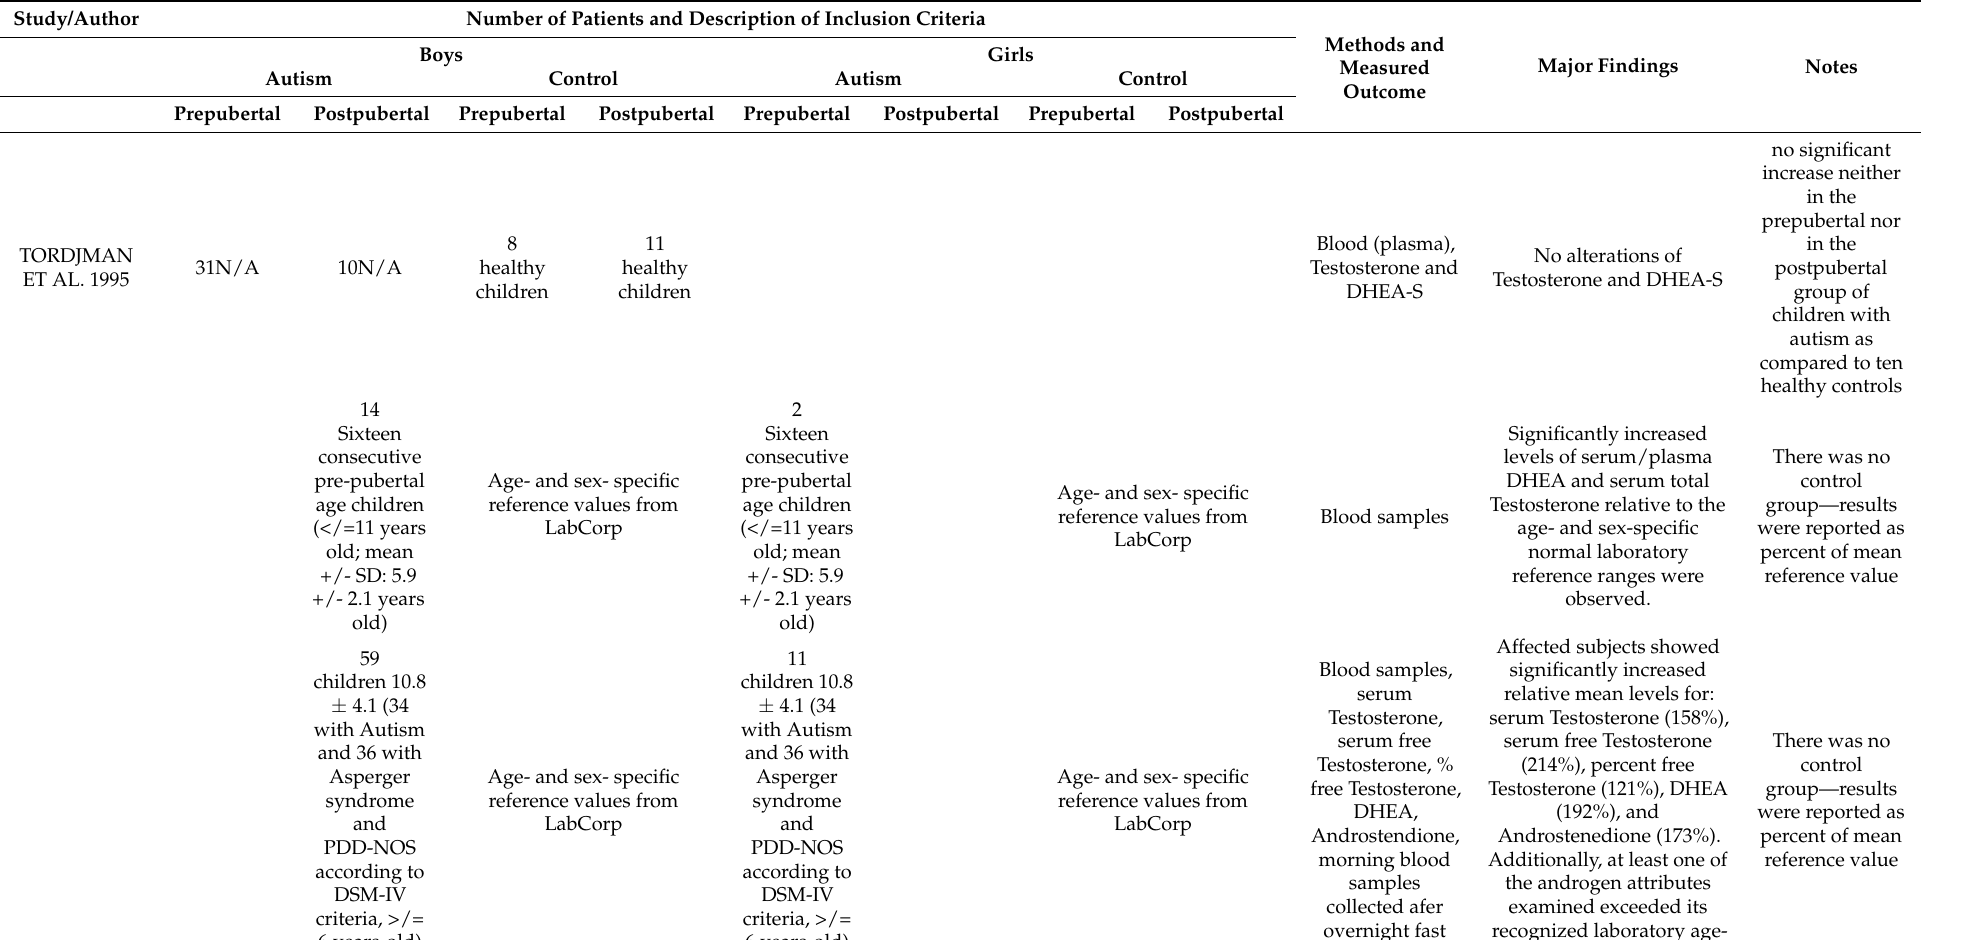
Table 1. Overview of the analyzed